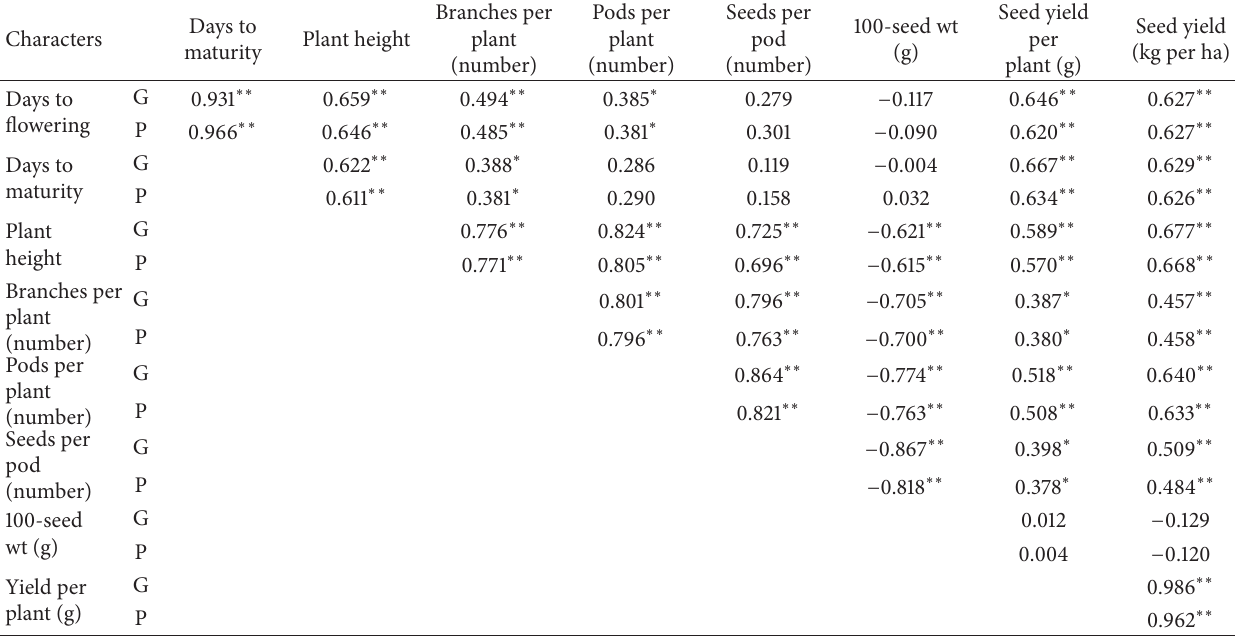
Table 6: Genotypic (G) and phenotypic (P) correlation coefficients among nine morphological traits in 31 soybean genotypes.